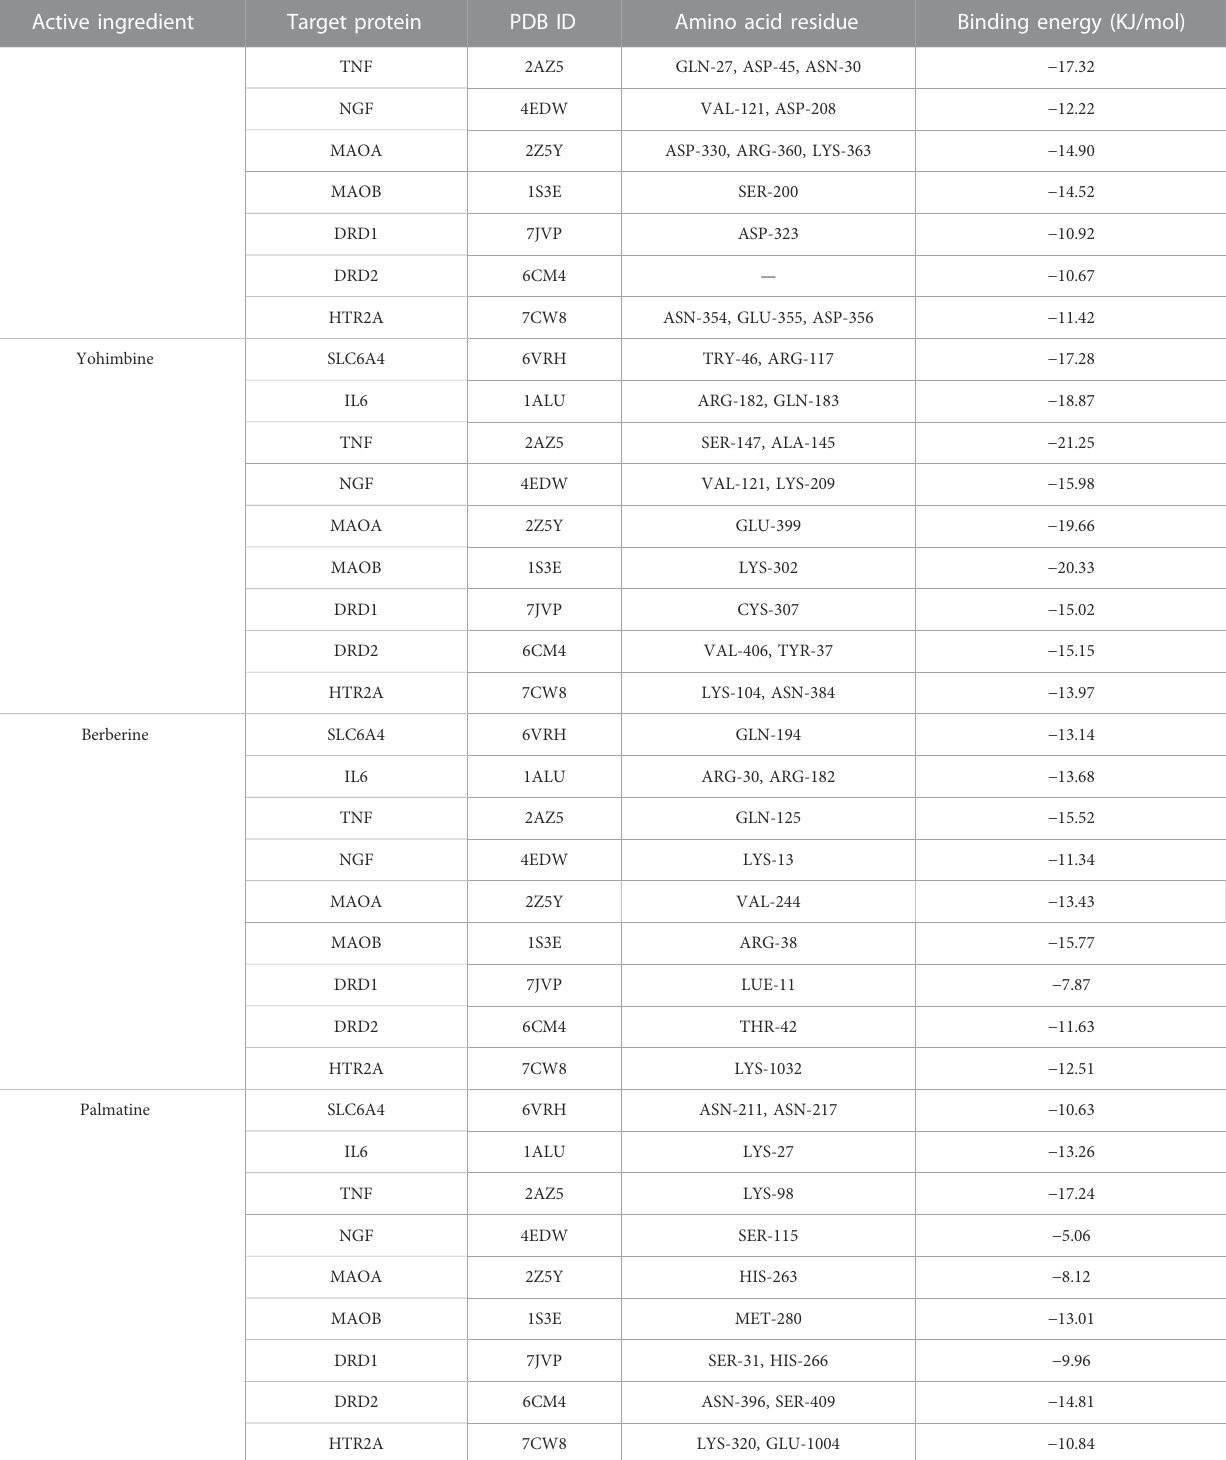
TABLE 6 ( Continued ) The binding energy of key active ingredients docked with target